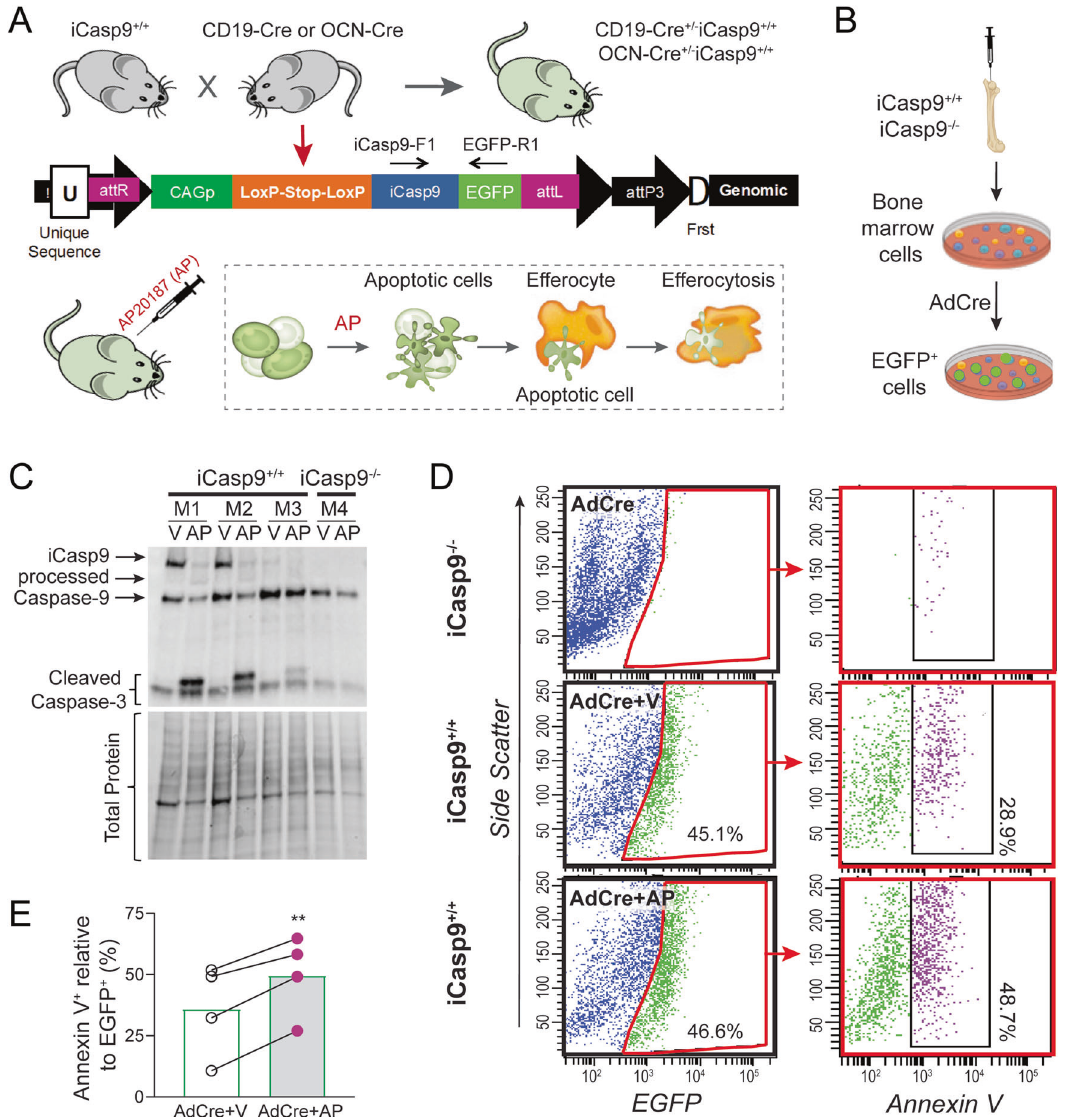
Fig. 1 iCasp9 mouse model and in vitro validation. A iCasp9 + / + mice crossed with Cre mouse lines (CD19-Cre or OCN-Cre) recombines the LoxP sites causing excision of the stop codon in the targeted construct allowing expression of iCasp9 and EGFP in Cre-expressing cells. The idea of the model is to inject AP20187 (AP) to dimerize and activate iCasp9, inducing apoptosis of target cells and subsequent efferocytosis. B Bone marrow cells from iCasp9 + / + mice and iCasp9 − / − littermates were cultured and transduced with adenovirus-Cre (AdCre) for 48 h. Isolated proteins were analyzed by C Western blot analysis showing expression of iCasp9, processed iCasp9, endogenous caspase-9 and cleaved caspase-3. Individual mice are indicated (M1 – M4). ( D Representative fl ow cytometry plots and proportion of EGFP + (left plots) and Annexin V + cells (right plots). ( E ) Percentage of Annexin V + signals in EGFP-expressing cells. Statistical signi fi cance was determined using paired t -tests comparing AP- and vehicle-treated cultures from the same animal. ** p < 0.01. n = 4